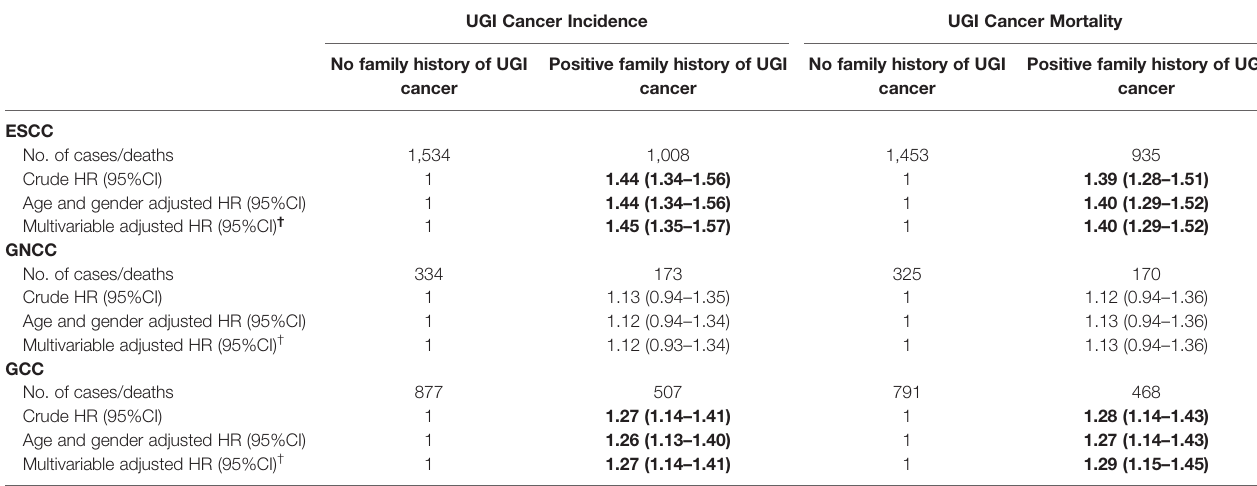
TABLE 6 | Sensitivity analysis by excluding individuals with less than 3 years follow up for the associations between family history of UGI cancer and risk of ESCC, GCC, and GNCC incidence and mortality.